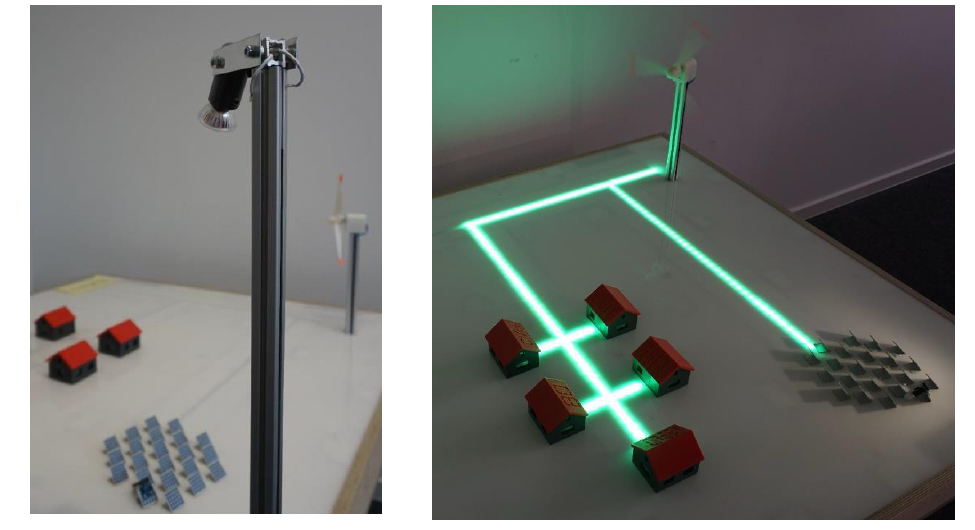
Figure 2. The smart grid